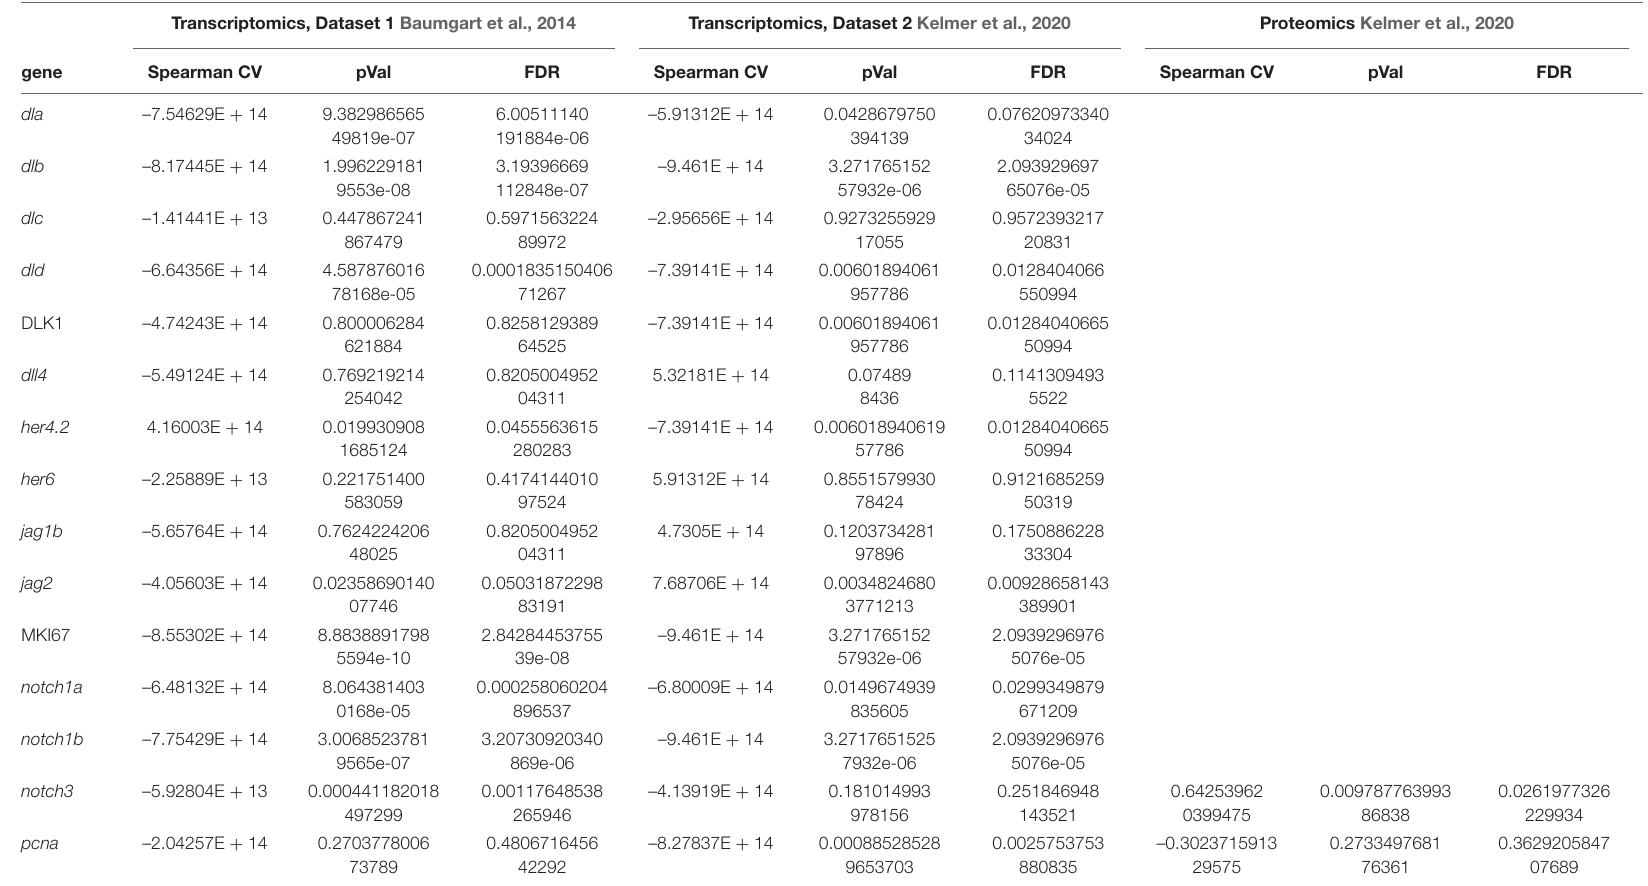
TABLE 2 | Spearman correlation value and respective p -values and adjusted p -values for gene and proteins listed in Figure 1 . Transcriptomics, Dataset 1 Baumgart et al.,